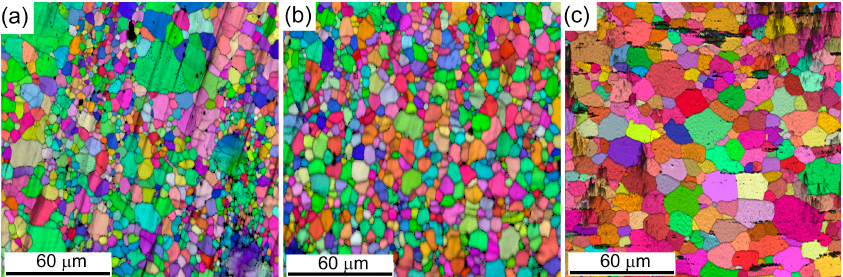
Figure 1. Electron backscattering diffraction (EBSD) maps of the longitudinal sections of the alloy ZK60 MIF-processed through one step at 400 °C ( a ) and two-steps at 400 °C and 300 °C ( b ), and ( c ) shows the grain structure of the hot extruded alloy WZ21.